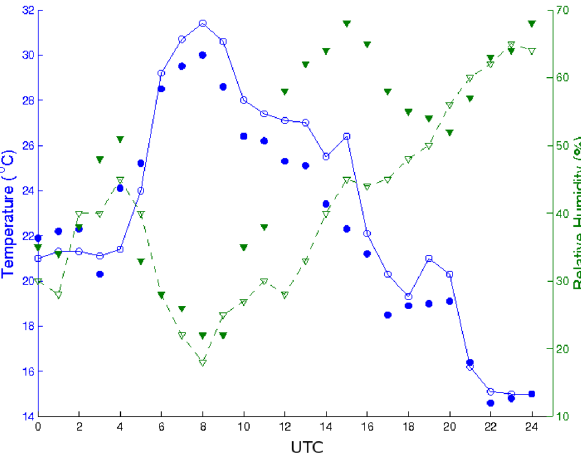
Fig. 6. Temporal evolution during 23 March 2008 of the 2m temper- ature (blue) and relative humidity (green) observed at the Heraklion weather station (closed symbols) and simulated by the WRF model (line and open